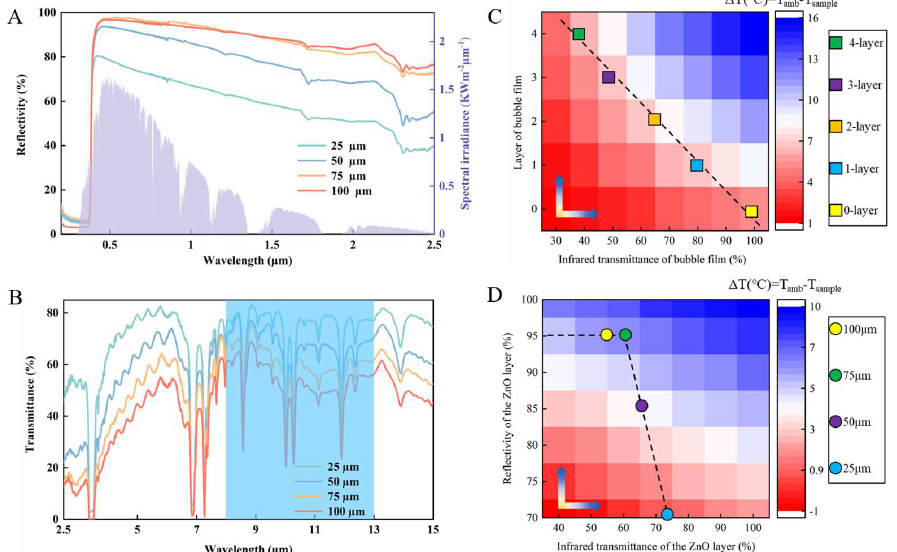
Figure 3. ( A ) Measured reflectance of different thicknesses of ZnO films over UV-VIS-NIR wavelengths, with the AM 1.5 solar spectrum. ( B ) Measured transmittance of different thicknesses of ZnO films over MIR wavelengths. ( C ) Model calculation: Setting the same object (PDMS, 200 μm) and ZnO (100 μm). Cooling results of object covered by 0–4 layers of bubble film. ( D ) Model calculation: Setting the same object (PDMS, 200 μm) and bubble film (2 layers). Cooling results of object covered by different thickness ZnO.